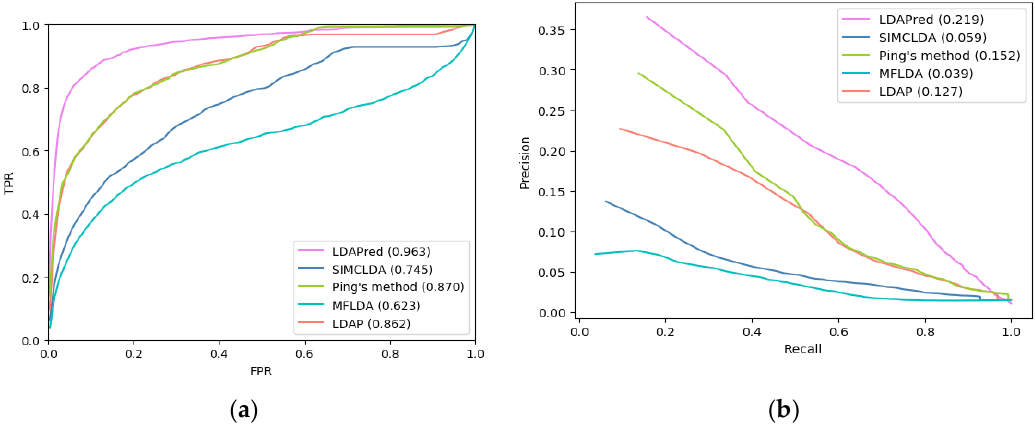
Figure 1. ( a ) Receiver operating characteristic (ROC) curves of LDAPred and the other four methods. ( b ) Precision–recall (PR) curves of LDAPred and the other four methods. Table 1. Area under ROC curves (AUC) of LDAPred and other methods for all diseases and 10 well-characterized diseases.